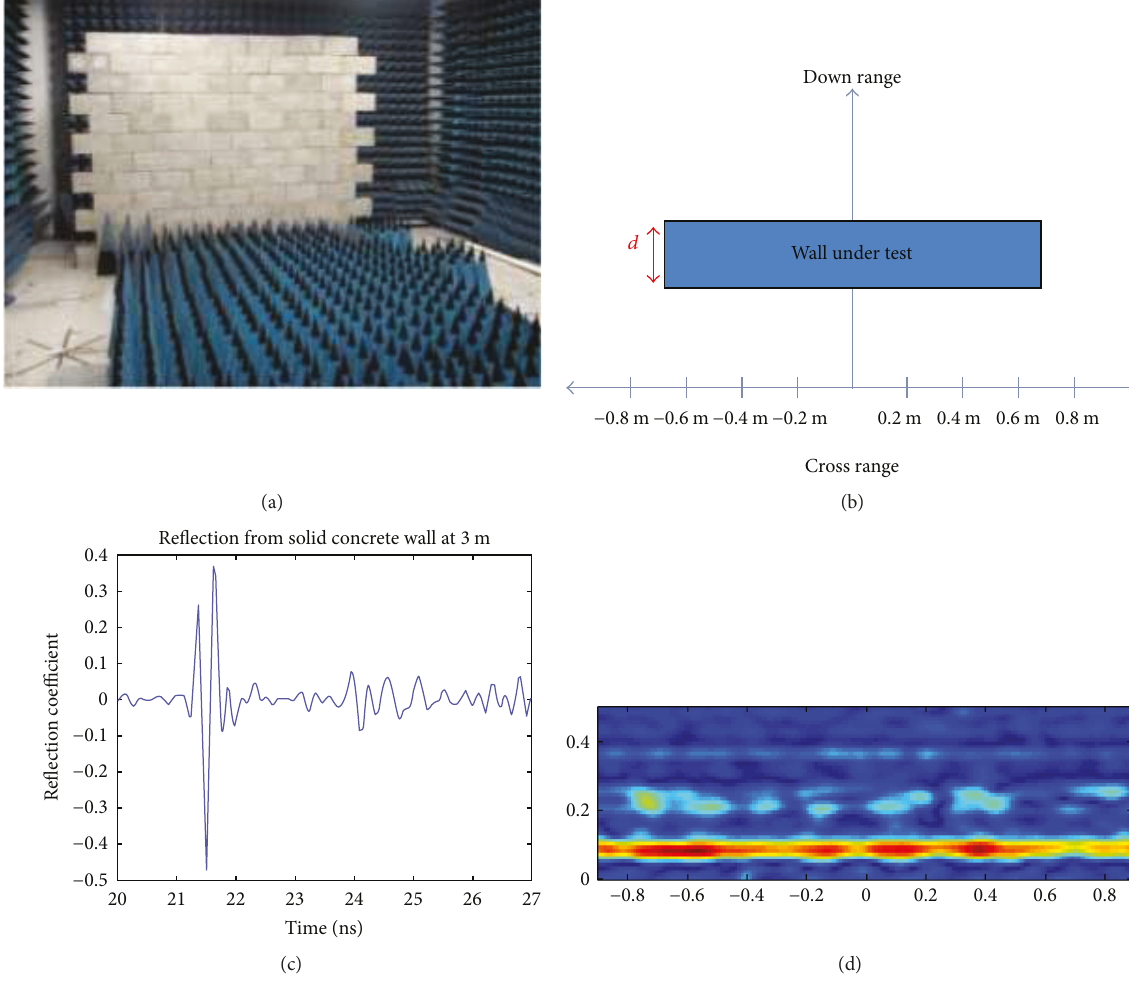
Figure 9: Solid concrete block wall with no backing. (a) Measurement setup. (b) Geometry. (c) Recorded re fl ection coe ffi cient. (d) Imaging